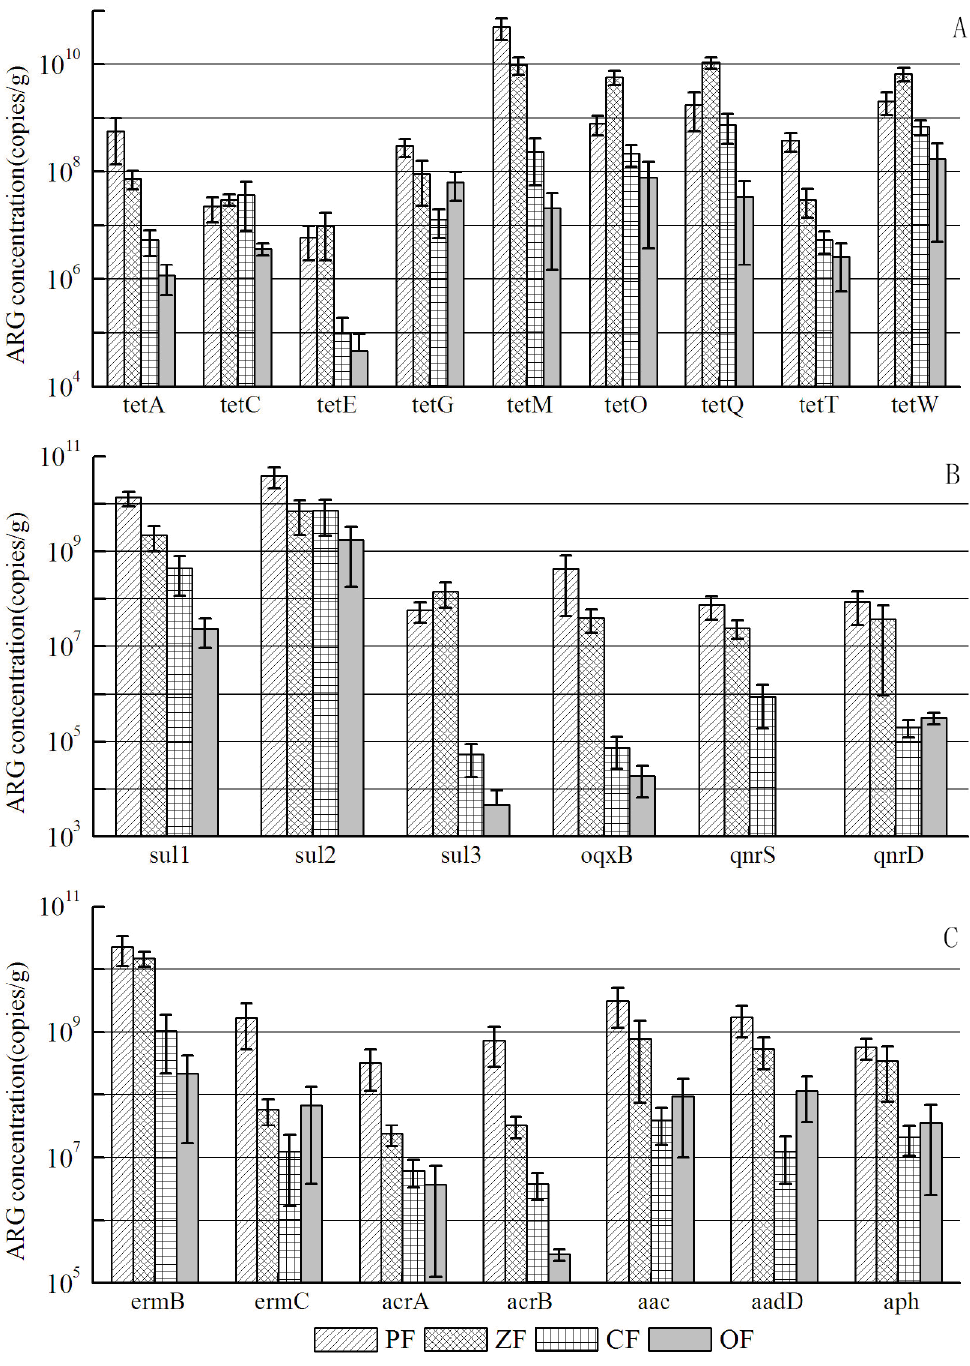
qnrS , qnrD; erm : ermB , ermC; acr : acrA , acrB; ami : aac , aadD , aph